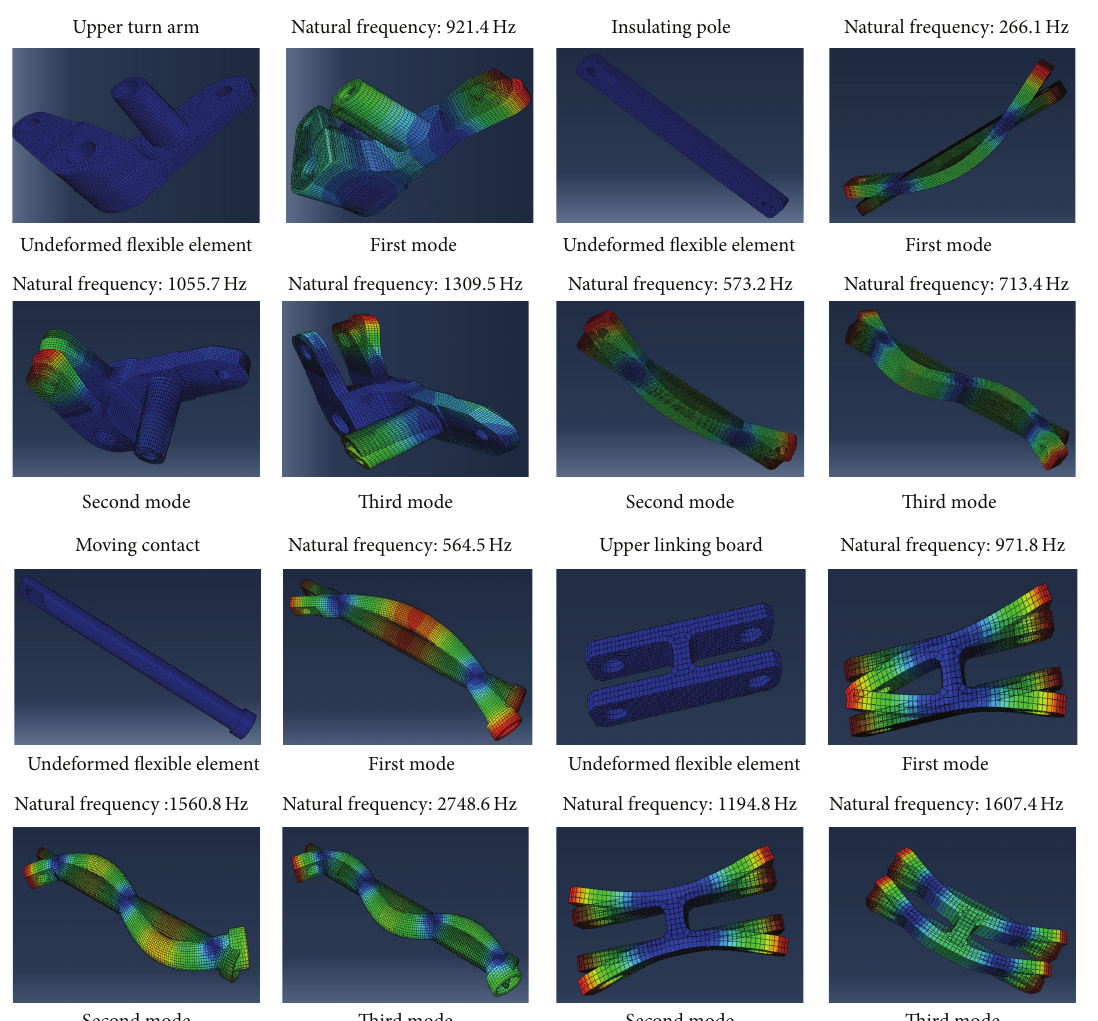
Figure 8: Flexible coupler: eigenfrequencies and eigenmodes